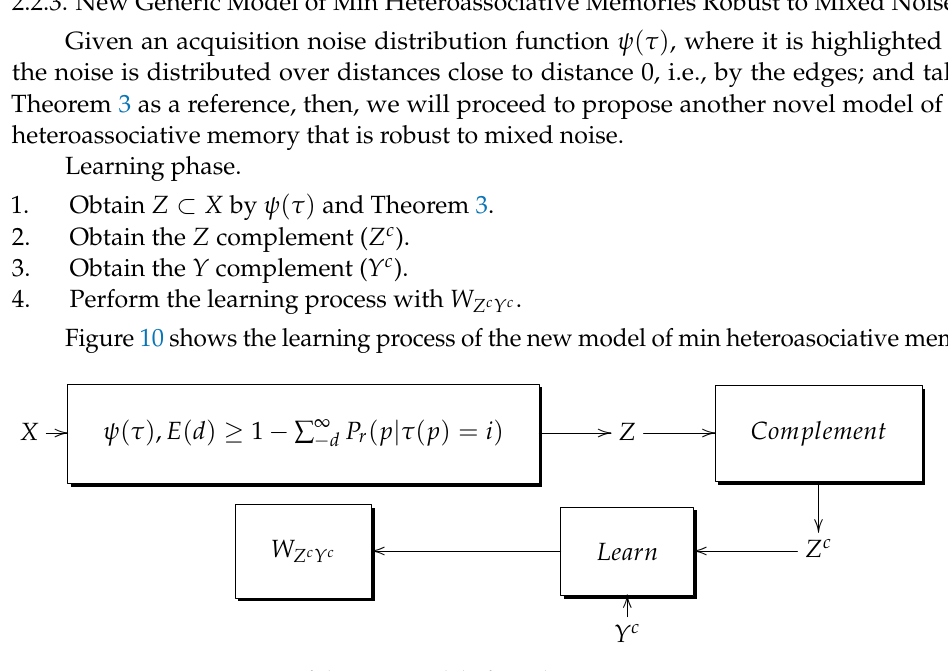
Figure 10. Learning process of the new model of min heteroassociative memories.